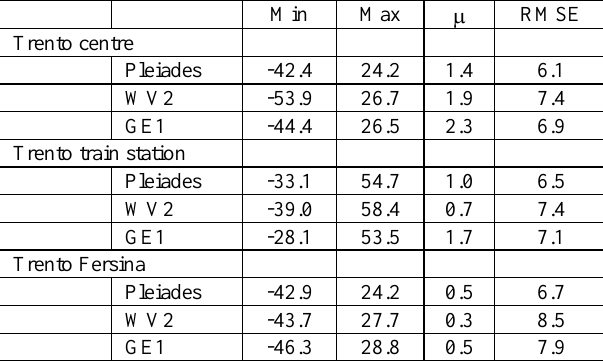
Table 4. Statistics of height differences of Pleiades, WV2 and GE1 DSMs with respect to Lidar for three study areas. Values are in